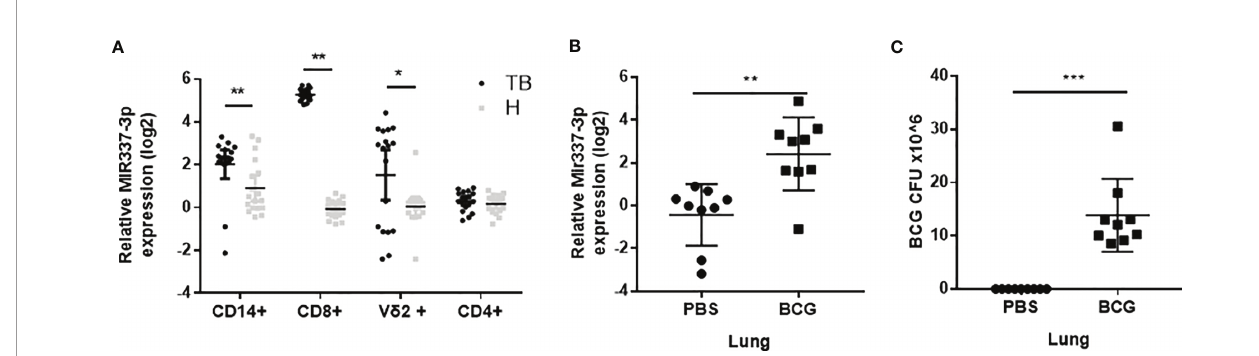
FIGURE 1 | MicroRNA MIR337-3p/Mir337-3p was highly expressed in lymphocytes of tuberculosis (TB) patients and in lungs of mycobacterium-infected mice. (A) The relative expression levels of MIR337-3p in CD14 + , CD8 + , and V g 2 + T cells in TB patients (n = 18) were signi fi cantly higher than the counterparts in healthy controls (HCs, n = 18), as measured by quantitative polymerase chain reaction (qPCR). (B) The expression of Mir337-3p in lungs of M. bovis BCG-infected mice were higher than those in phosphate buffered saline (PBS)-infected animals (n = 9). (C) The M. bovis Bacillus Calmette-Guerin (BCG) infection levels in lungs of BCG- infected mice (n = 9). Data are represented as mean ± standard errors. *P < 0.05, **P < 0.01, and ***P <